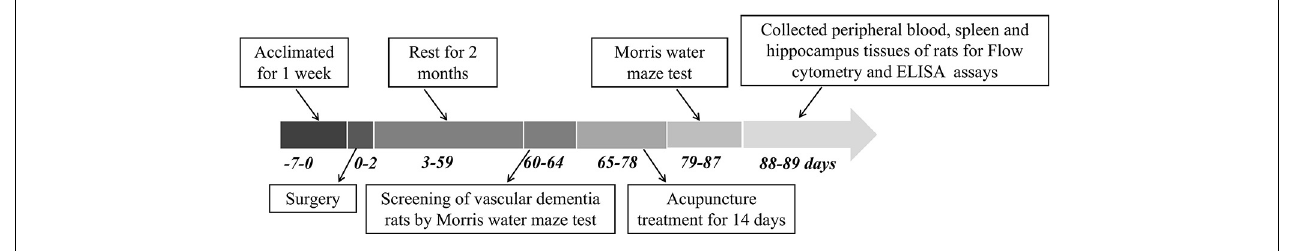
FIGURE 1 | Detailed time course schema of